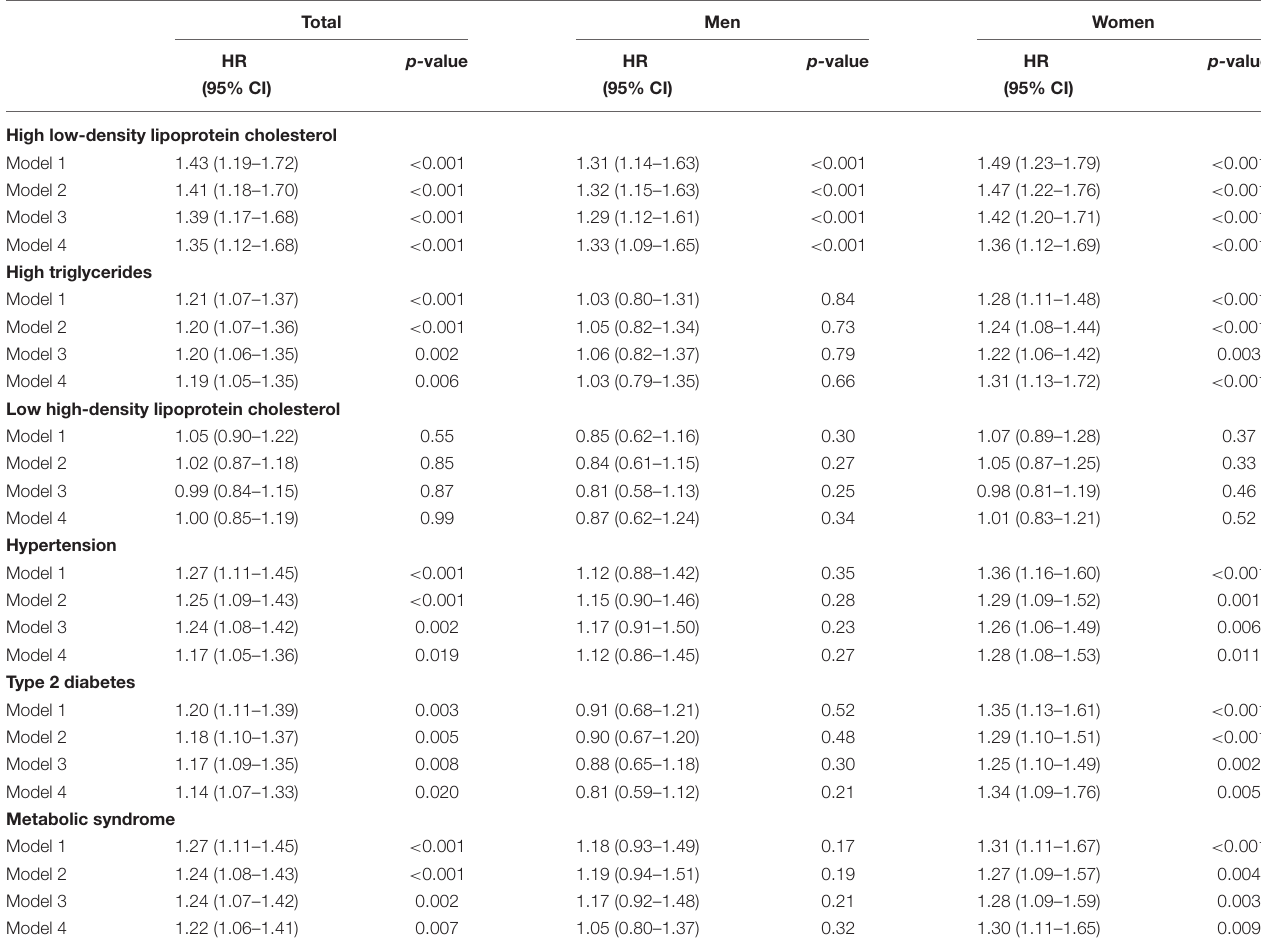
TABLE 3 | Multivariable Cox regression of cardiometabolic risk factors on per 1-SD increment in PCSK9.